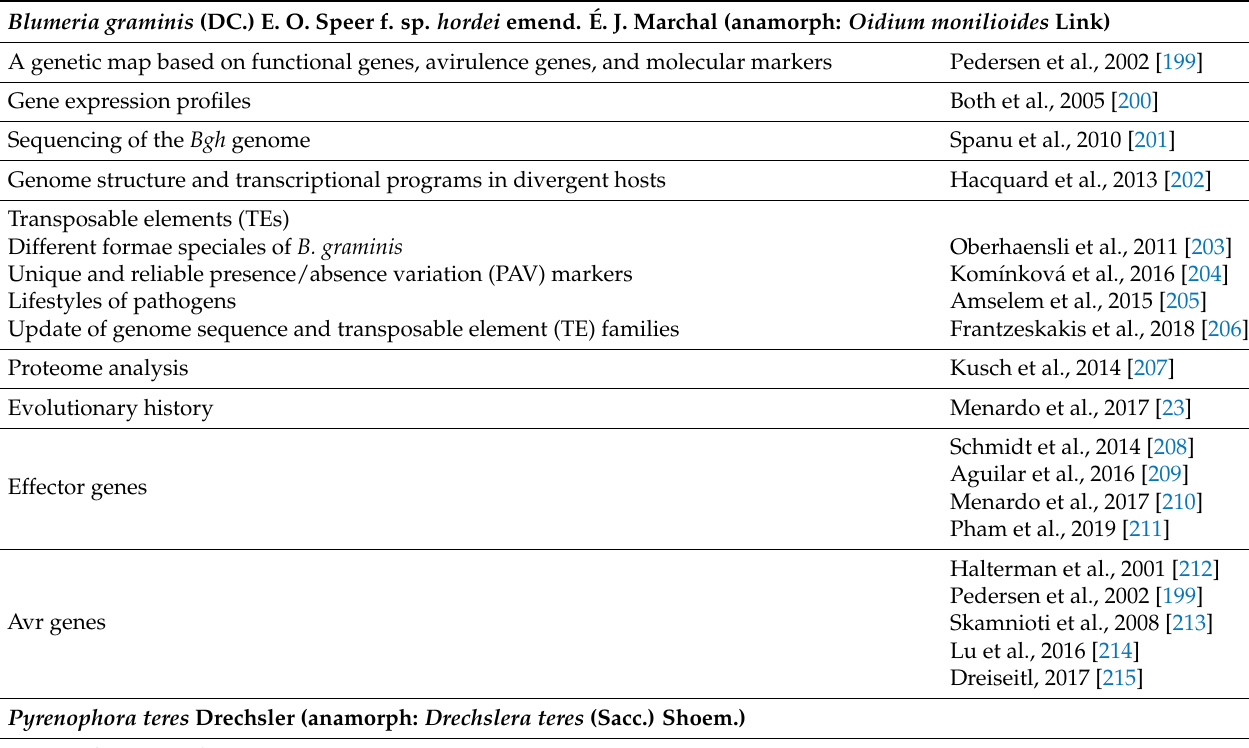
Table 1. Some important studies on the genomes of major barley